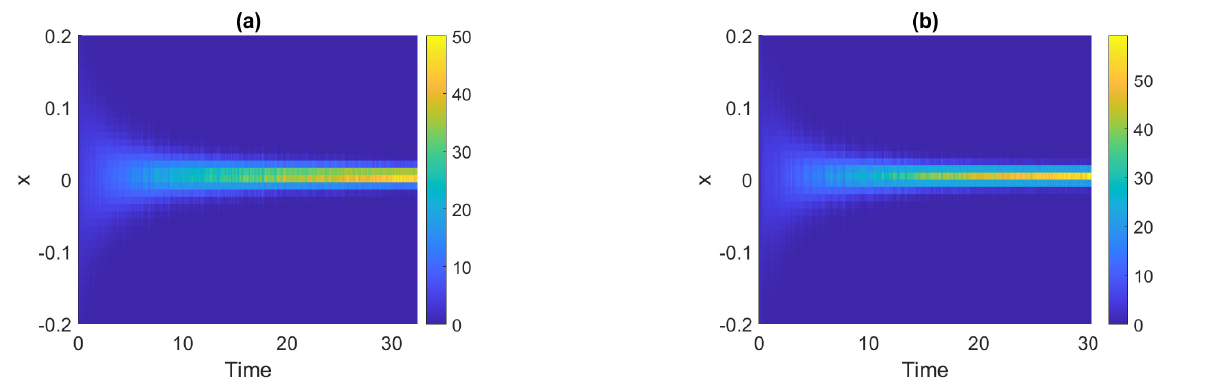
Figure 4. Density maps for Signal 1 (panel ( a )) and Signal 2 (panel ( b